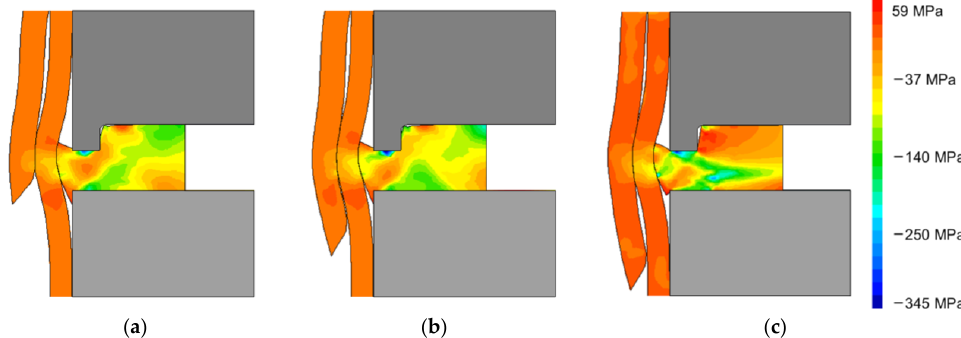
Figure 5. Distribution of radial stress for a PVC – PVC tube combination for different penetration depths d p : ( a ) 18 mm, ( b ) 22 mm and ( c ) 24 mm.